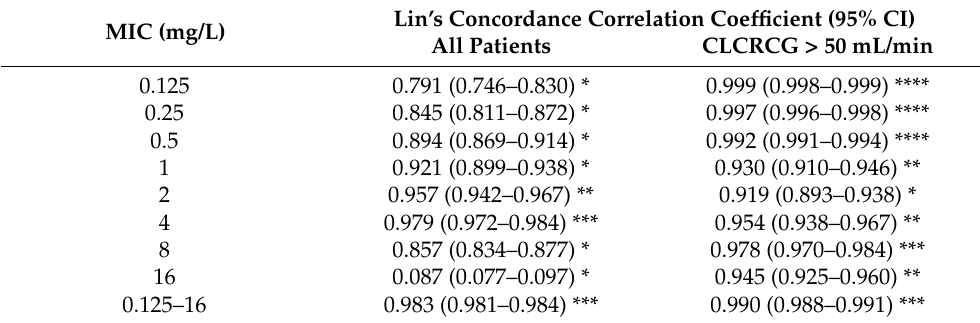
Table 2. Lin’s concordance correlation coefficient for risk predictions by pharmacokinetic model and MeroRisk-Calculator. Lin’s Concordance Correlation Coefficient (95% CI) MIC (mg/L) All